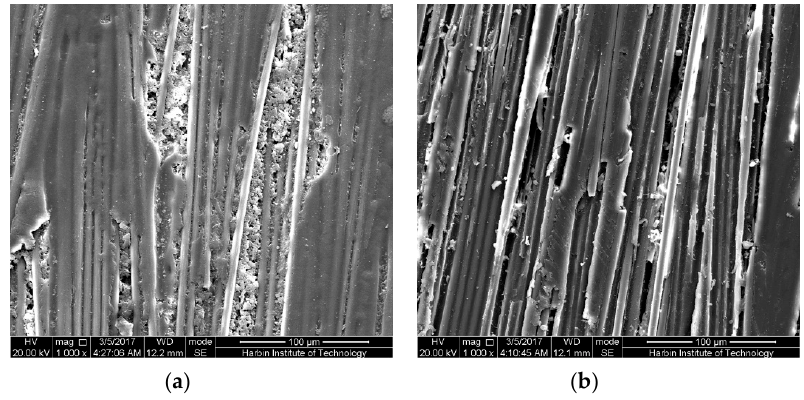
Figure 15. The bottom surfaces in the mid-span region of the epoxy-based CFRP samples subjected to 58% of strain level and seawater immersion for 6 months: ( a ) 20 °C, ( b ) 60 °C.